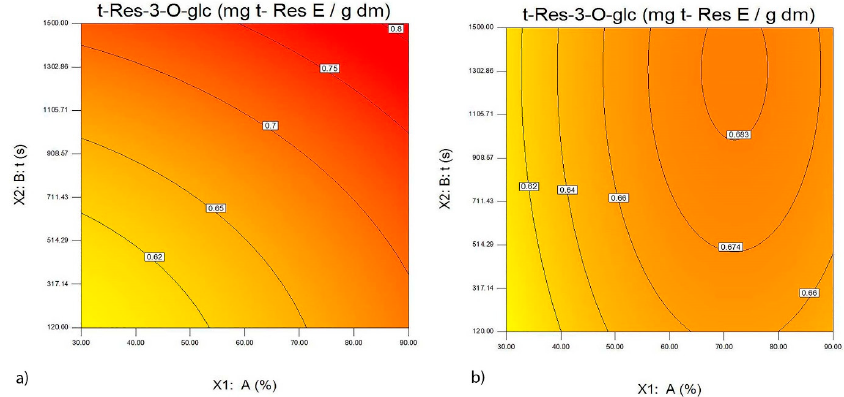
Figure 2. The effect of the probe with a diameter of 22 mm ( a ), probe with a diameter of 40 mm ( b ), amplitude A (%) and the ultrasound extraction time t (s) on the quantity of trans -resveratrol glucoside expressed as the trans -resveratrol equivalent (mg/g d.m.) in the extracts of wine lees from the Merlot variety.